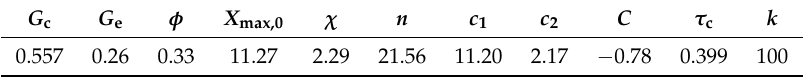
Table 2. Material parameters used in the sensitivity analysis and in the